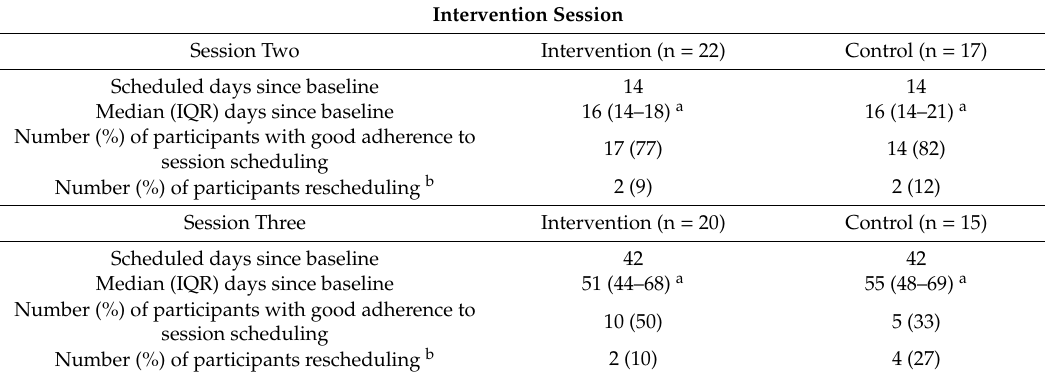
Table1. Studyrecordsoftiming(dayssincebaseline)ofinterventionsessionsintheFoodFixintervention randomised controlled